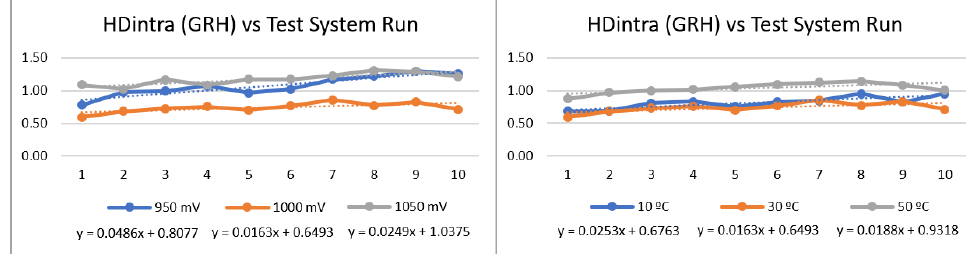
Figure 20. HDintra mean under voltage ( left ) and temperature ( right ) variations, applying the challenge selection strategy over two PUF instances of the test system implemented in the Nexys A7